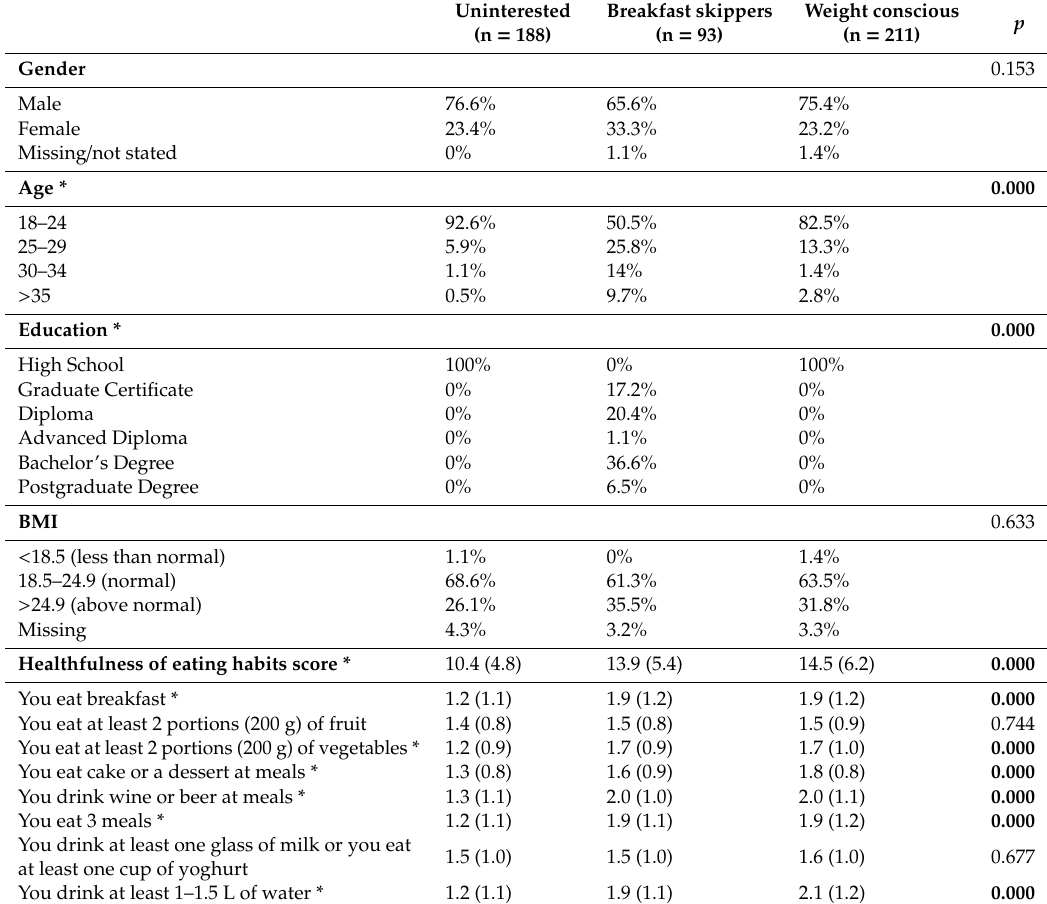
Table 4. Three segment solution—demographic and behavioural